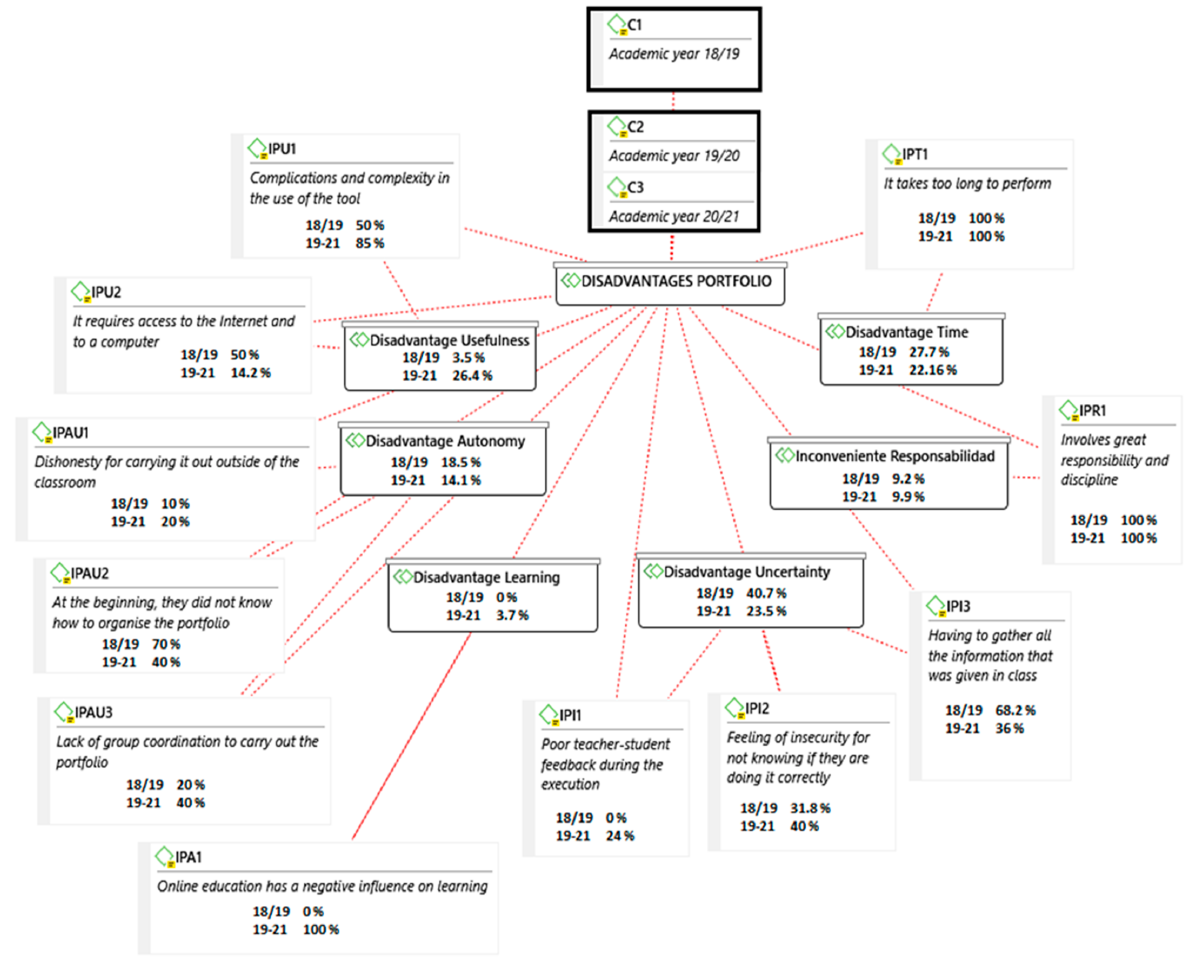
Figure 4. Disadvantages of the digital portfolio before and during the COVID-19 pandemic.